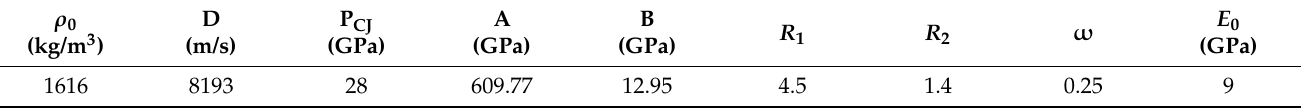
Table 1. Properties of PE4 used in the computational simulations